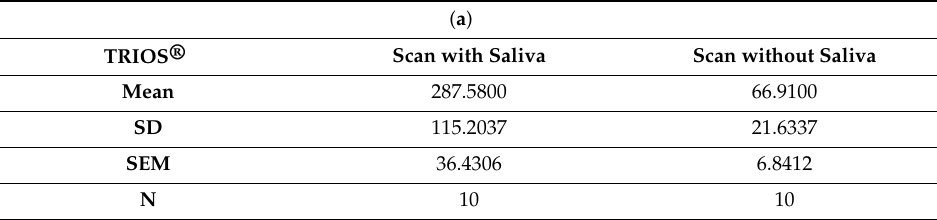
Table 10. t -test sample